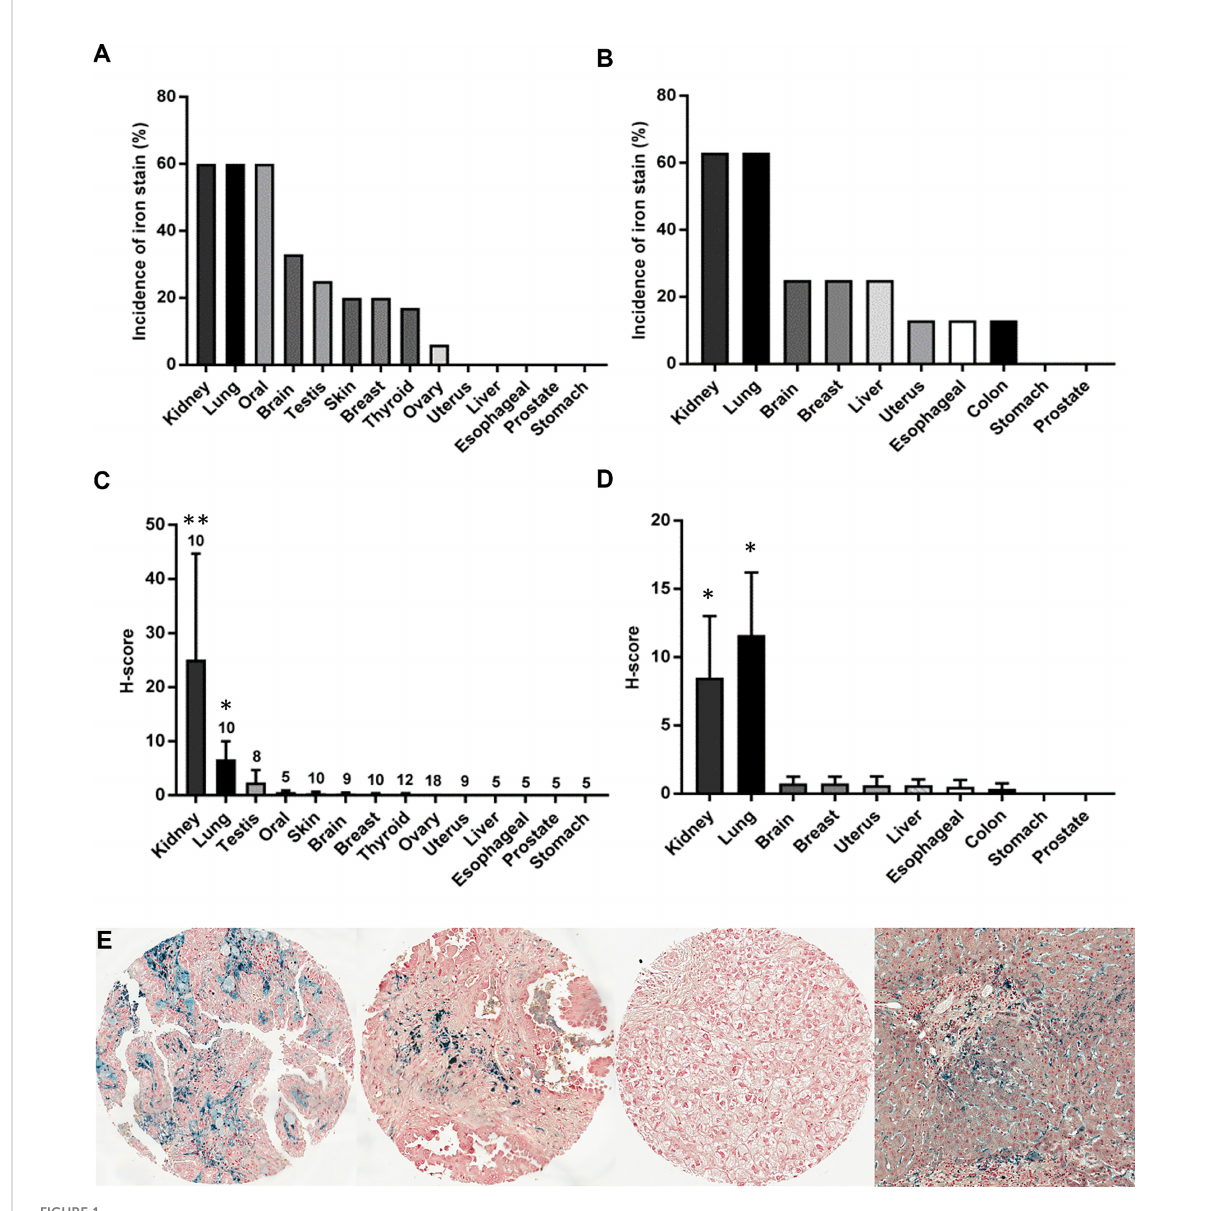
FIGURE 1 Kidney cancer has high levels of iron compared with other common cancers. The incidence and mean tissue level (H-score) of non-heme iron staining was compared across a variety of cancer types using two different TMA sources: (A, C) the RPCCC multi-cancer TMA that included primary tumor tissue from 14 different body sites and (B, D) the Biomax multi-cancer TMA that included primary tumor tissue from 10 different body sites. The number of patients evaluated for each tumor type in the RPCCC TMA is indicated above the error bar, and eight patients were evaluated for each tumor type in the Biomax TMA. (E) Representative staining images are shown at low power magni fi cation for (left to right) kidney cancer (RCC), lung cancer, liver cancer, and hemochromatosis liver as a positive staining control for iron overload. *p < 0.01 vs . all other cancers; **p < 0.001 vs . all other